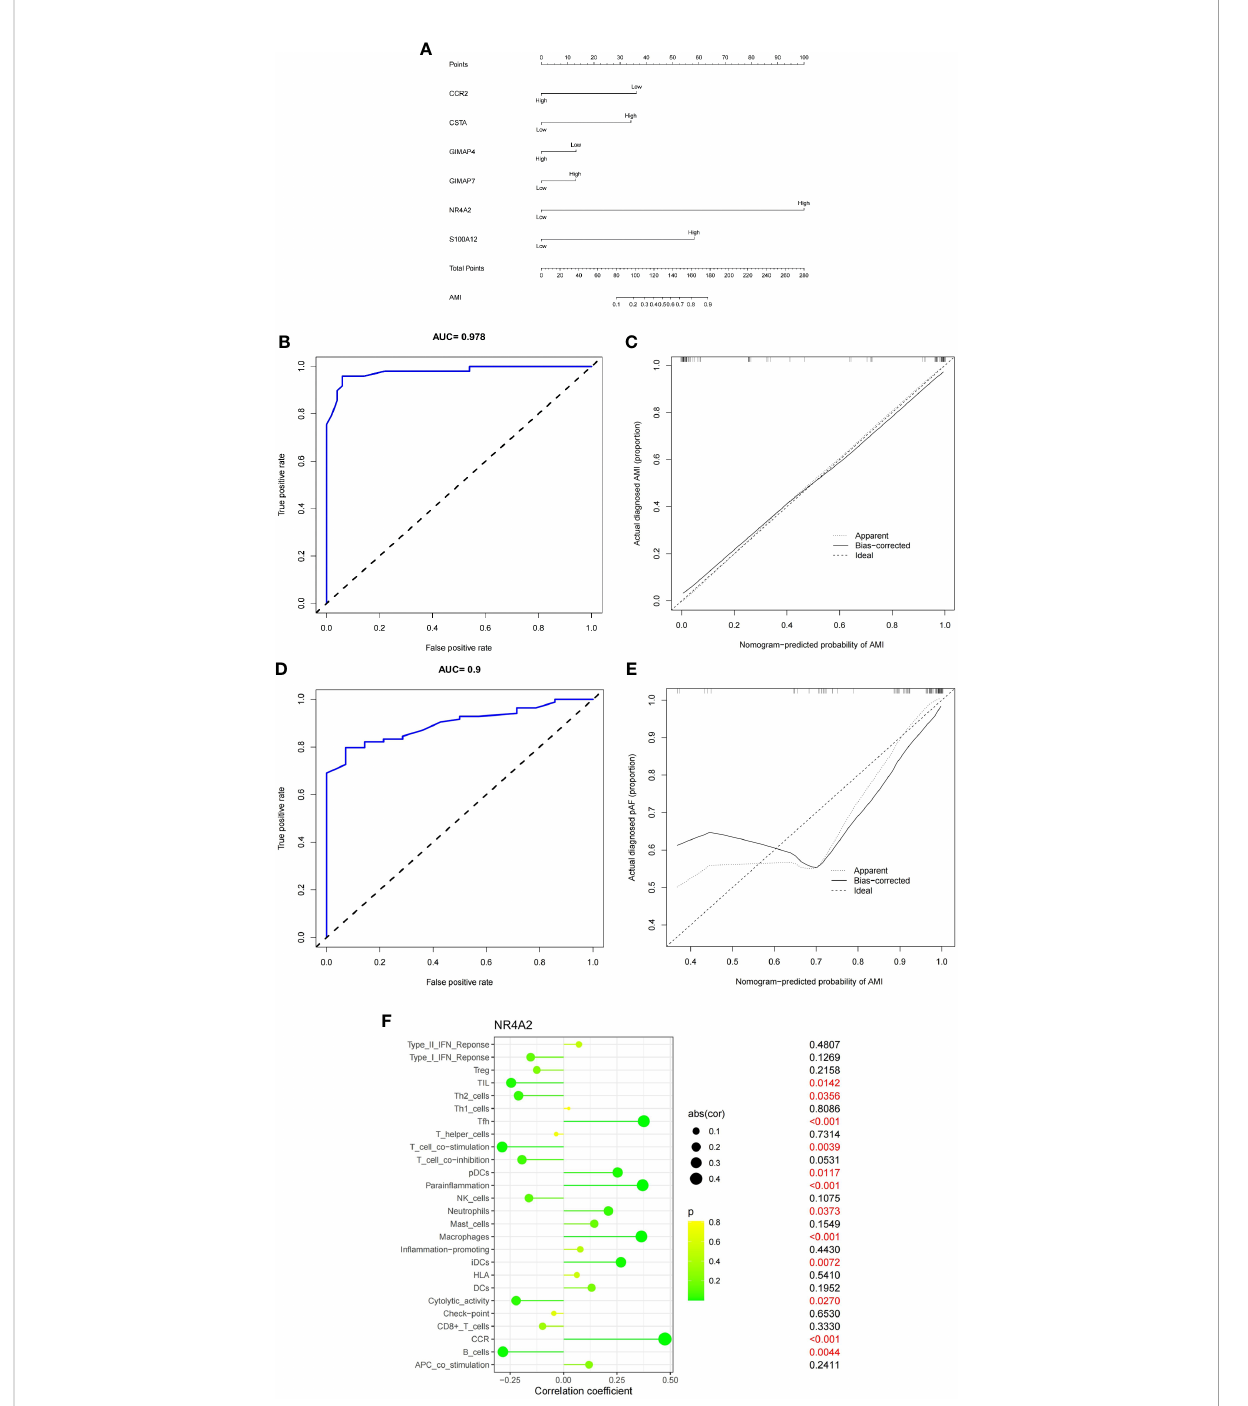
FIGURE 8 (A) Six genes (CCR2, P=0.07;CSTA, P=0.18; GIMAP4, P=0.69; GIMAP7, P=0.71; NR4A2, P=0.0004; S100A12, P=0.04) were utilized to establish a nomogram for the diagnosis MI. (B) ROC curves of the nomogram. (C) Calibration chart of the diagnostic model. (D) ROC curves of the nomogram in the validation set. (E) Calibration plots for validation sets. (F) Correlation of NR4A2 with in fi ltrating immune cells in MI and normal